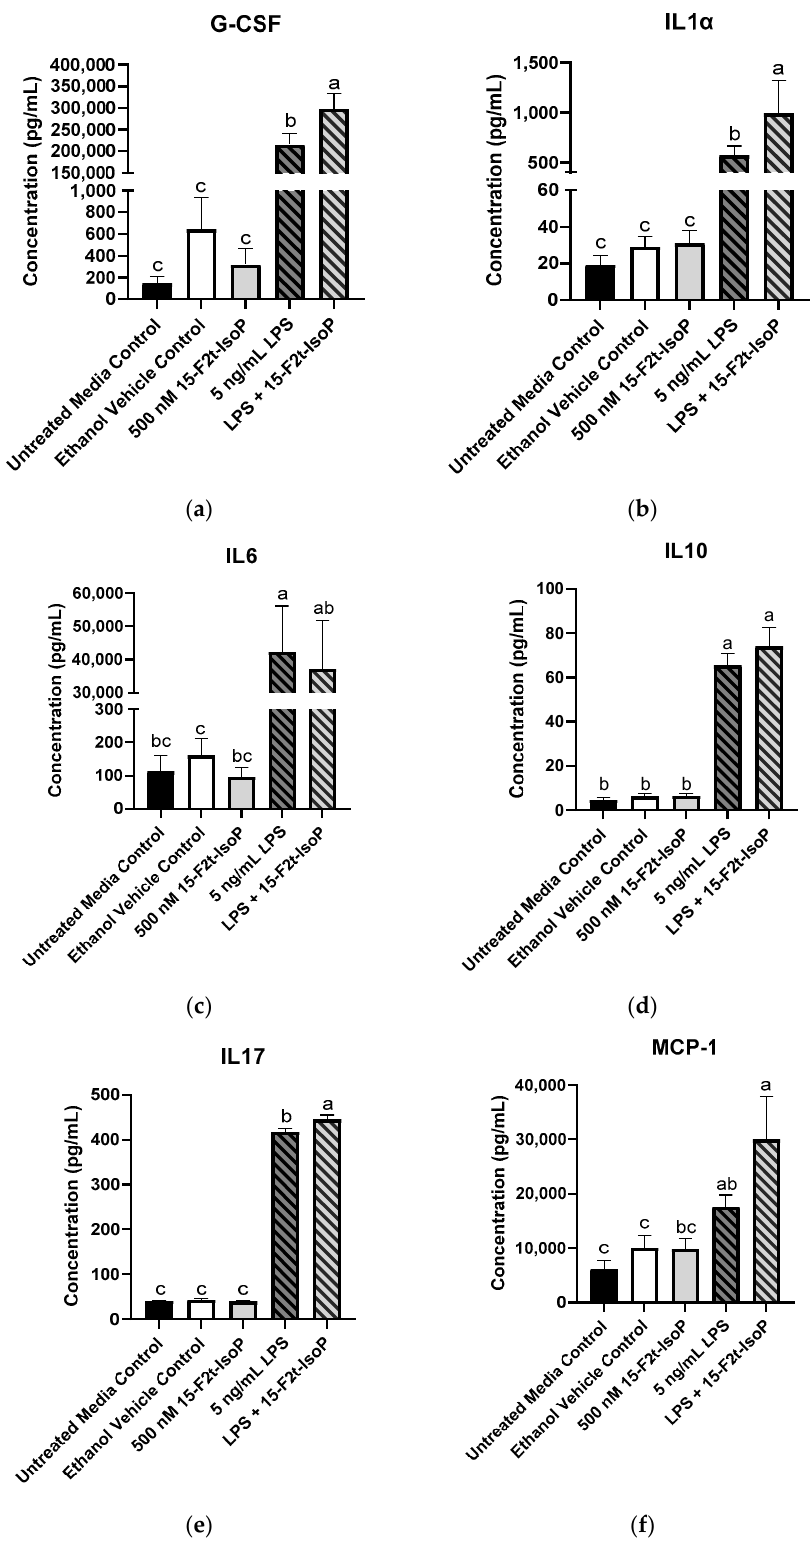
Figure 5. Mean cytokine concentrations in RAW 264.7 cells ( n = 7) challenged with endotoxin and 15-F 2t -isoprostane. ( a ) Granulocyte colony-stimulating factor (G-CSF), ( b ) interleukin (IL) 1 α , ( c ) IL6, ( d ) IL10, ( e ) IL17, ( f ) monocyte chemoattractant protein-1 (MCP-1). Statistical analyses included a one-way ANOVA with Tukey’s HSD posthoc test. a–c Different superscripts are different ( p < 0.05); LPS—lipopolysaccharide;